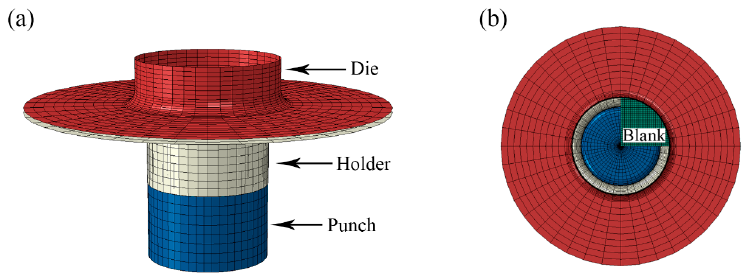
Figure 19. Marciniak test FE model: ( a ) front view; ( b ) vertical view. Table 9. Experimental procedure for Biaxial-plane stain/shear loading.